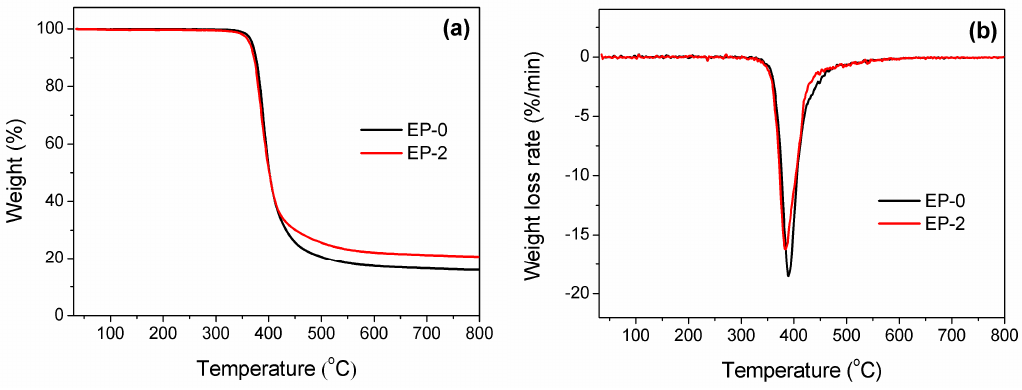
Figure 4. ( a ) TGA and ( b ) DTG curves of the cured epoxy.